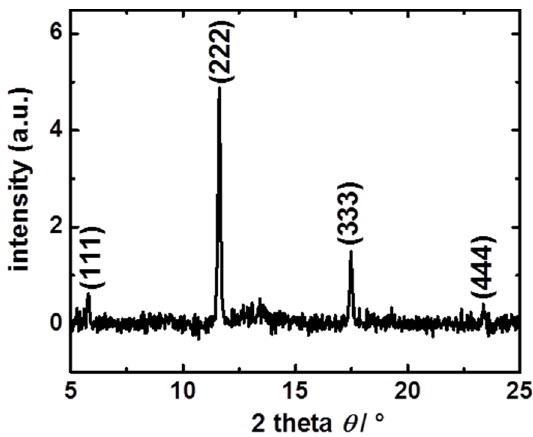
Figure 2. X-ray diffractogram of the HKUST-1 SURMOF. The diffraction reflexes at 5.8° (111), 11.6° (222), 17.5° (333) and 23.3° (444) demonstrate the crystallinity of